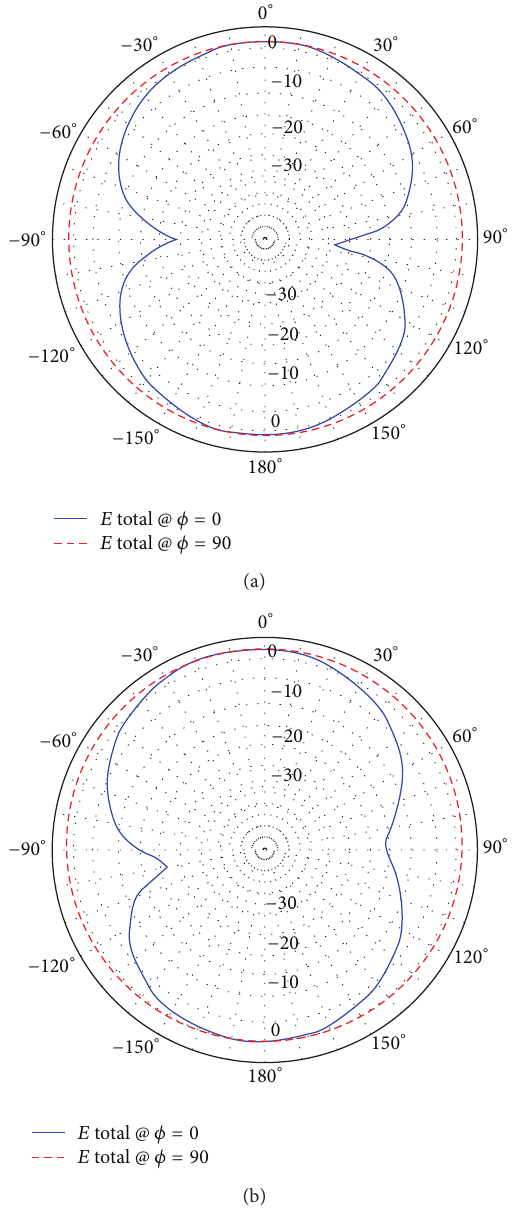
Figure 9: Radiation patterns of (a) the reduced size version of the low band antenna at 750 MHz and (b) the reduced size version of the high band antenna at 2.7 MHz.